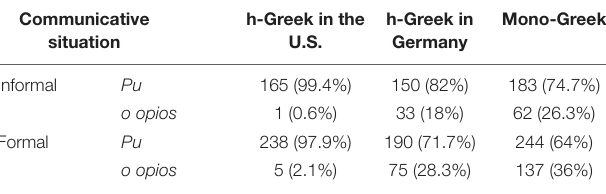
TABLE 3 | Quantitative data - distribution of restrictive RCs in different registers per